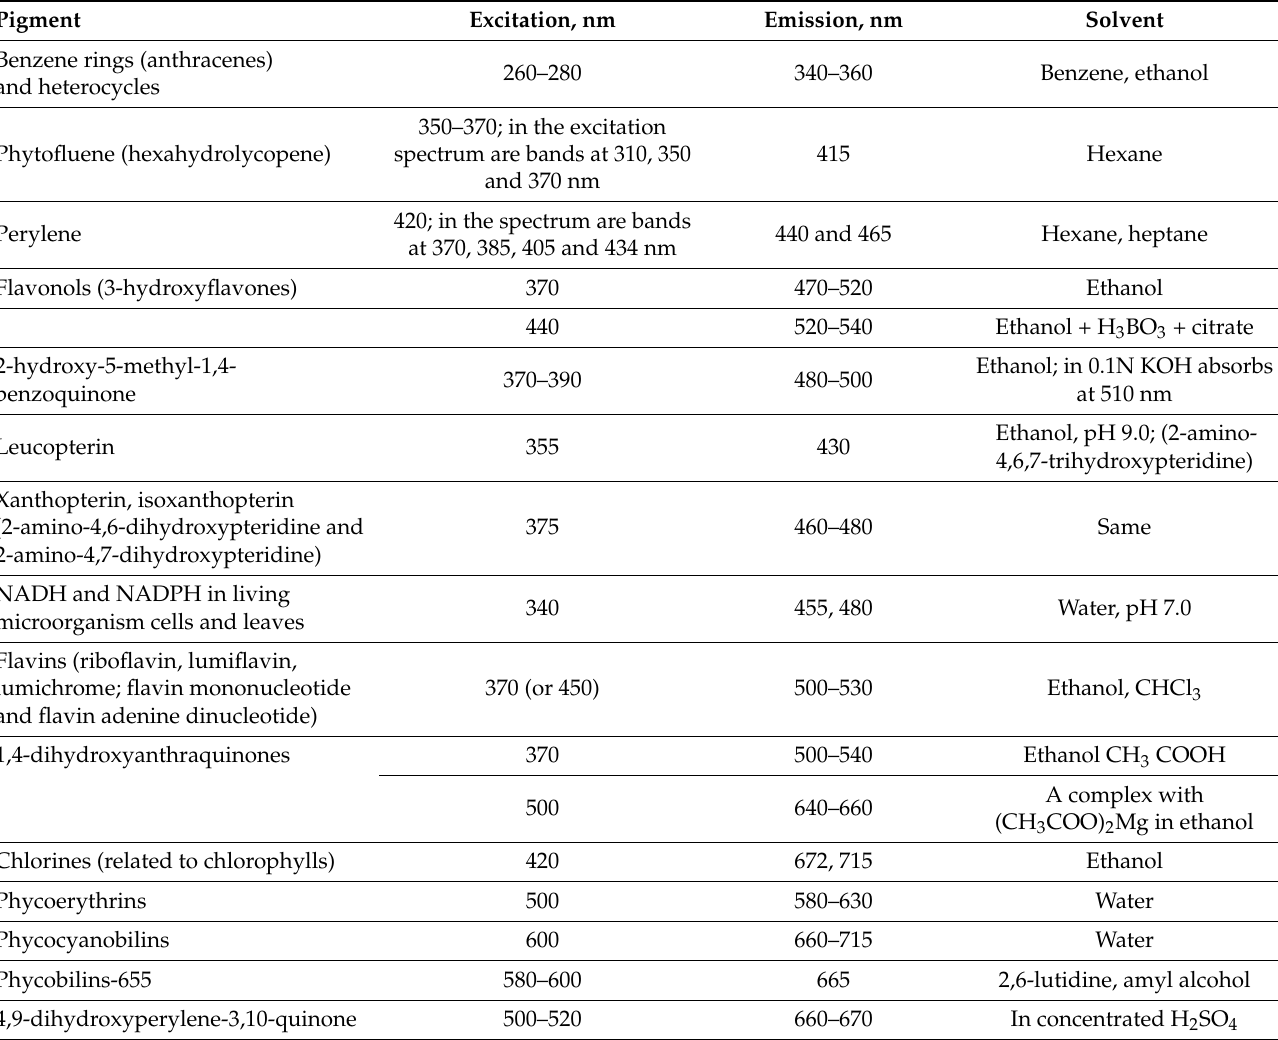
Table 2. Fluorescence compounds (pigments) in soil and their spectral